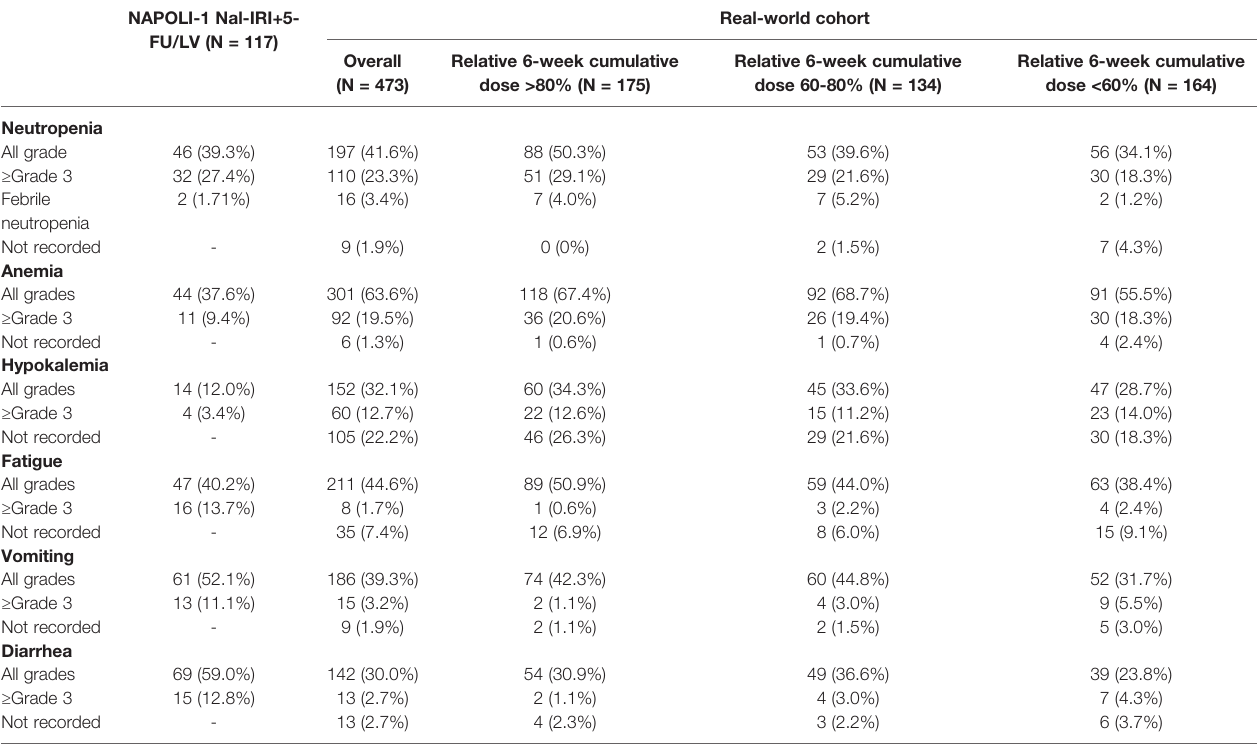
TABLE 5 | Adverse effects in different 6-week cumulative dose